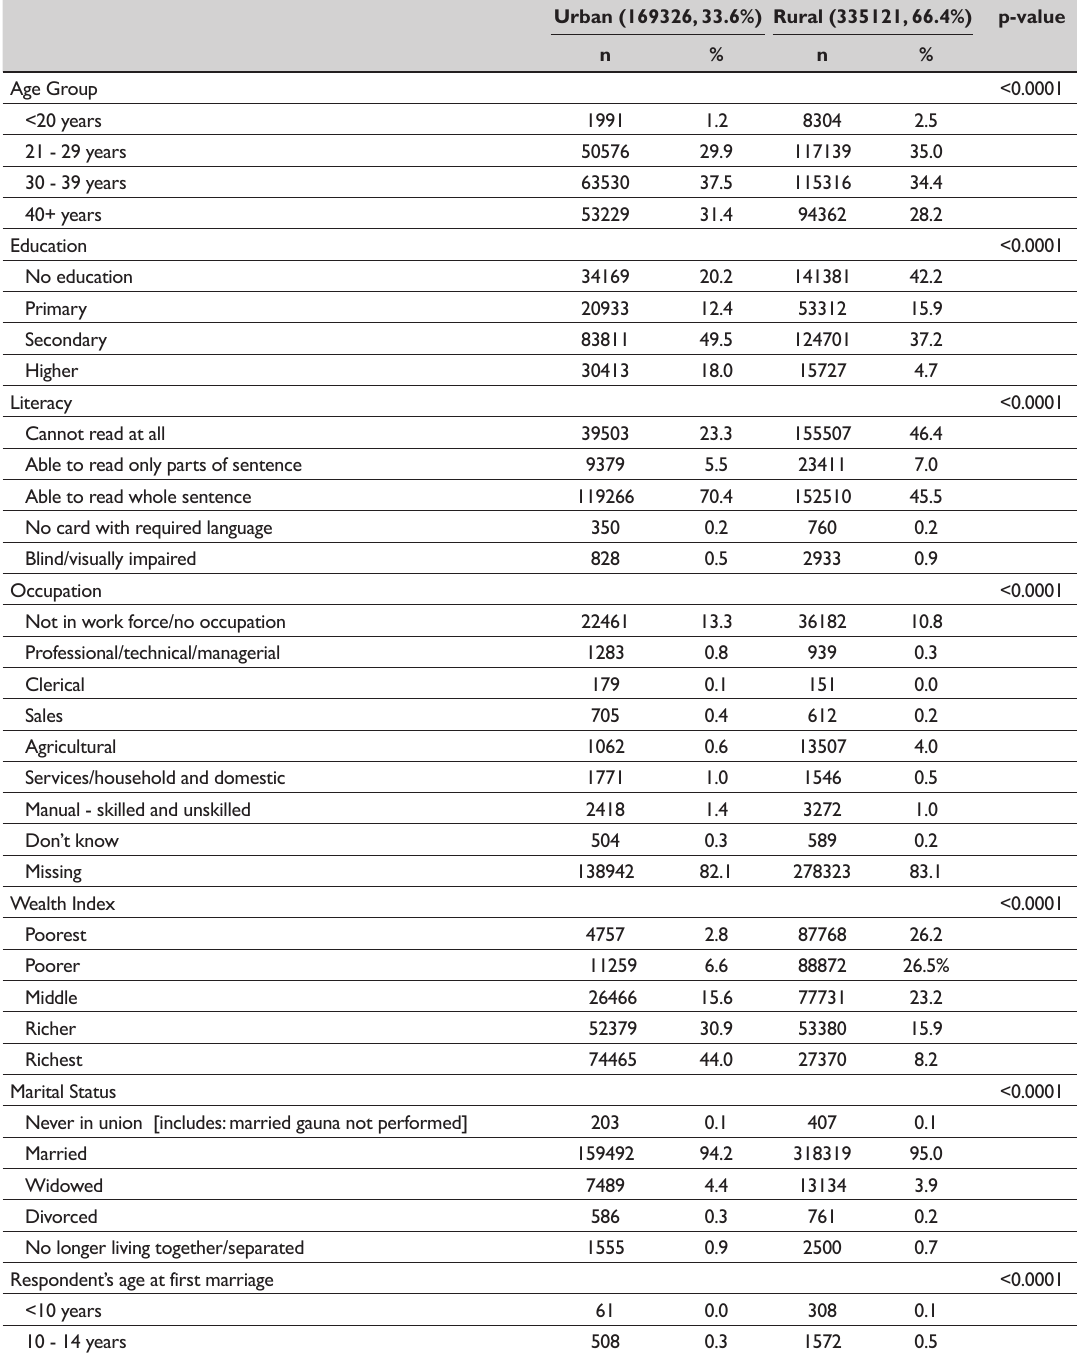
Table 1: Socio-demographic characteristics of women stratified by place of